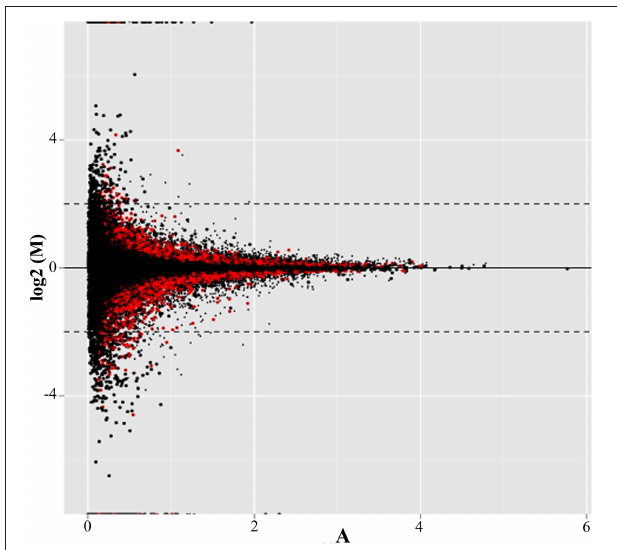
FIGURE 1 | MA-plot showing the distribution of differentially expressed genes. The y-axis shows the log 2 -transformed FC of expression between cold stress treatment and the control. The x-axis, meanwhile, corresponds to the log 2 -transformed average expression level for each gene across all samples (FPKM). Points in red represent those genes for which p < 0.01 . Dashed lines correspond to log 2 FC ≥ | 2 |